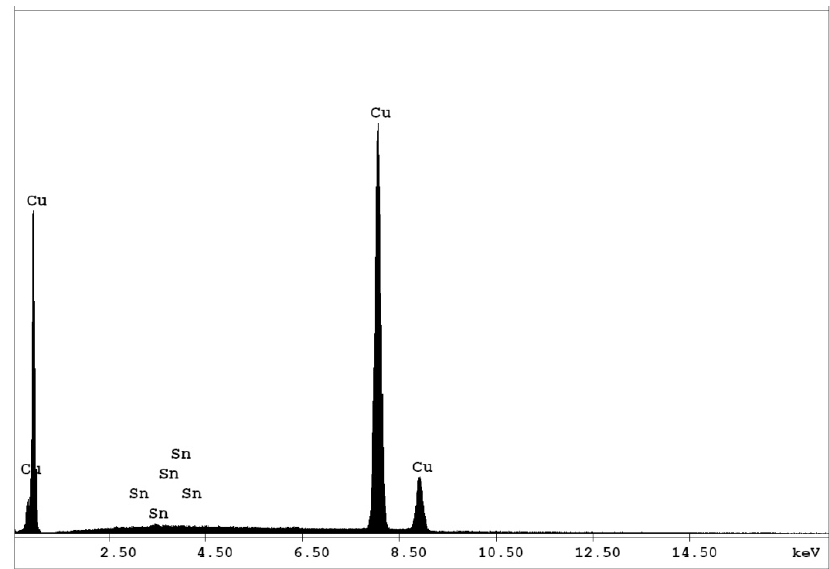
Figure 1. EDAX spectrum of the copper deposit.